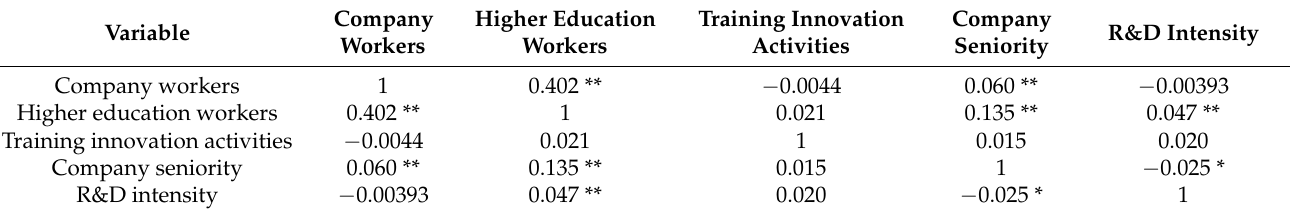
Table 2. Pearson correlations of variables.